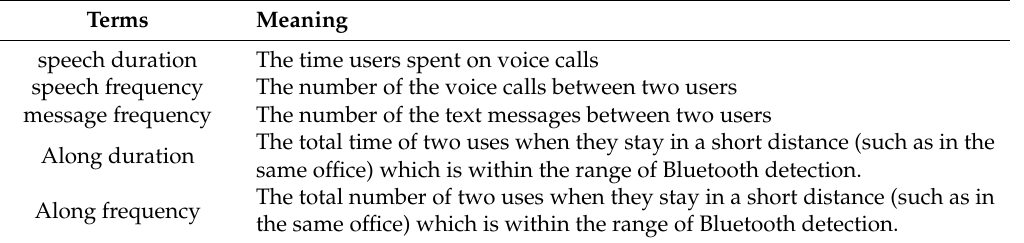
Table 1. The index of terms used in this